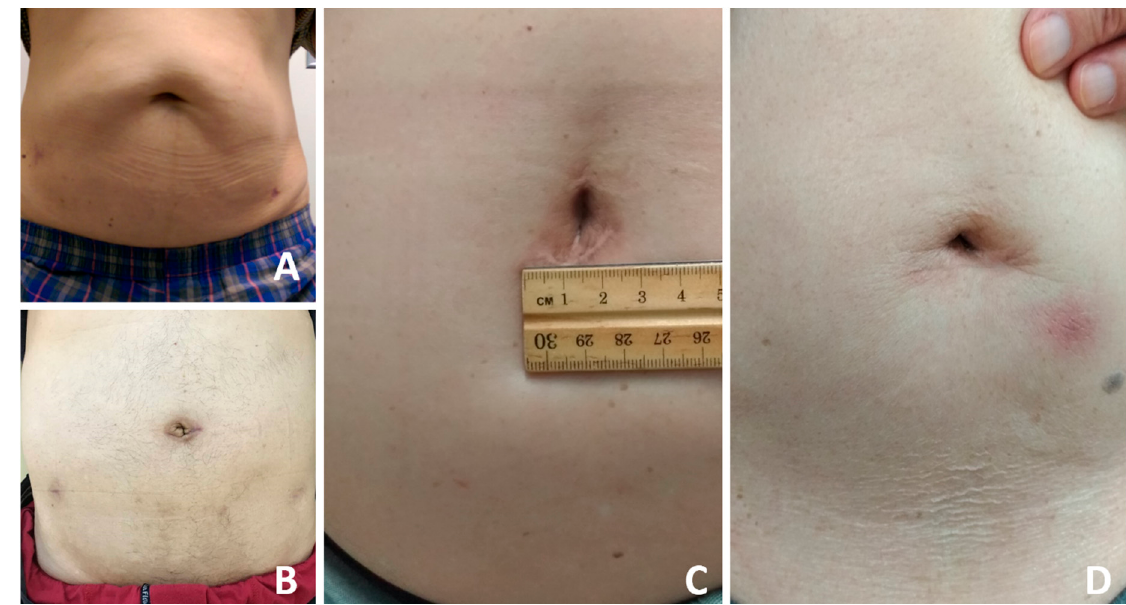
Figure 2. The umbilical scar one year later ( A – D ).